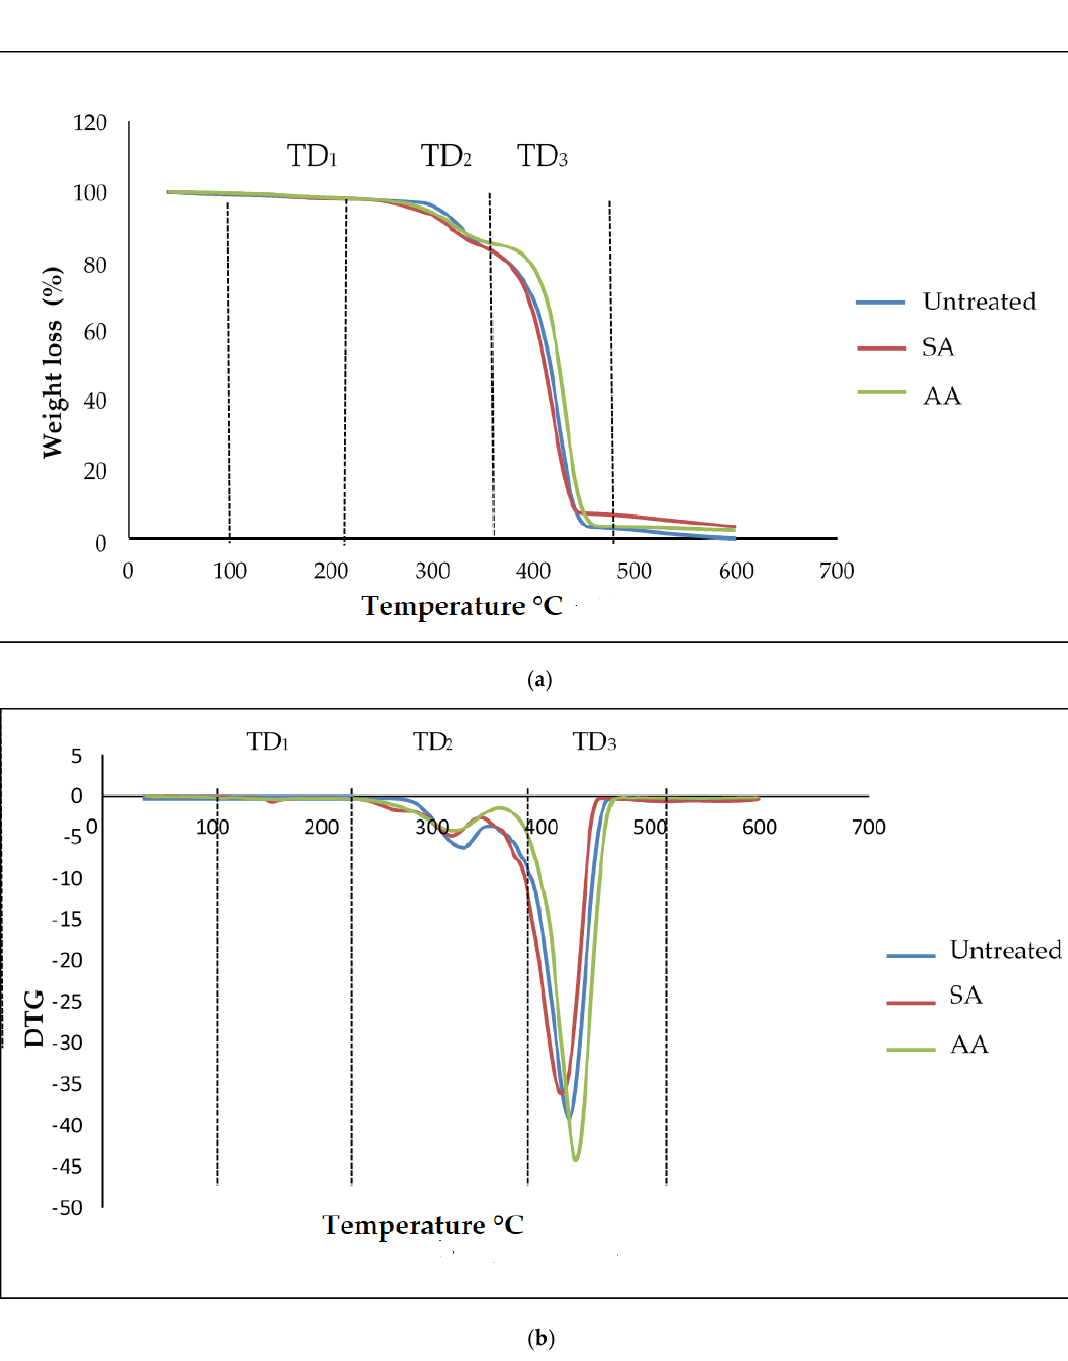
Figure 11. ( a ) TGA curves of PS/TPS blend with a ratio of 20/80 (TPS/PS). ( b ) DTG curves of blend with a ratio of 20/80 (TPS/PS).